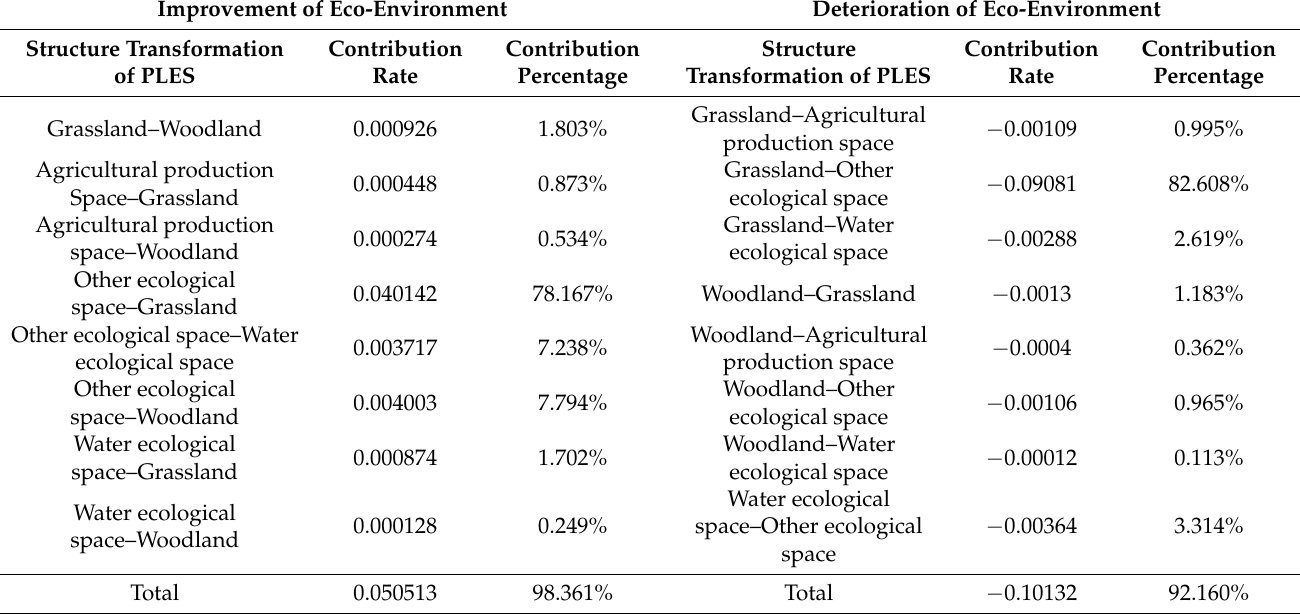
Table 5. The major PLES land use transformation types influencing eco-environmental quality, their contribution rate, and ratio from 1980 to